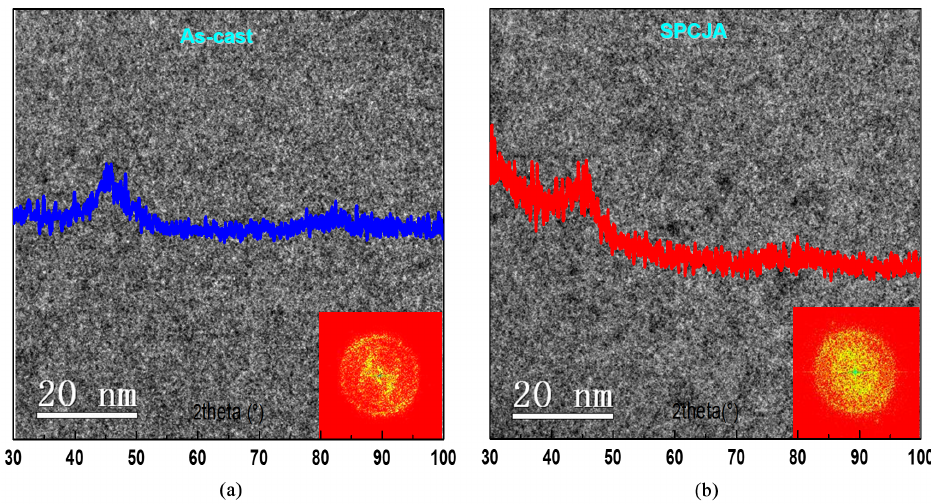
Figure 1. XRD patterns and corresponding HRTEM images including the insets of selected area electronic diffraction (SAED) patterns of as-cast microwire (a) and SPCJA-ed microwire